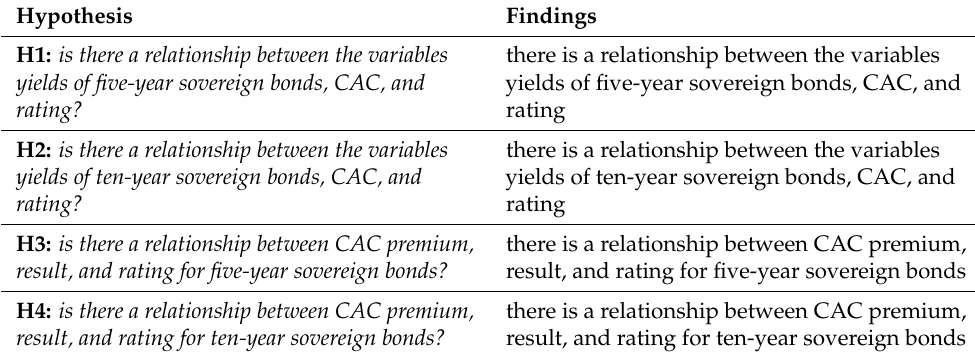
Table 5. Summary of key empirical findings (Source: